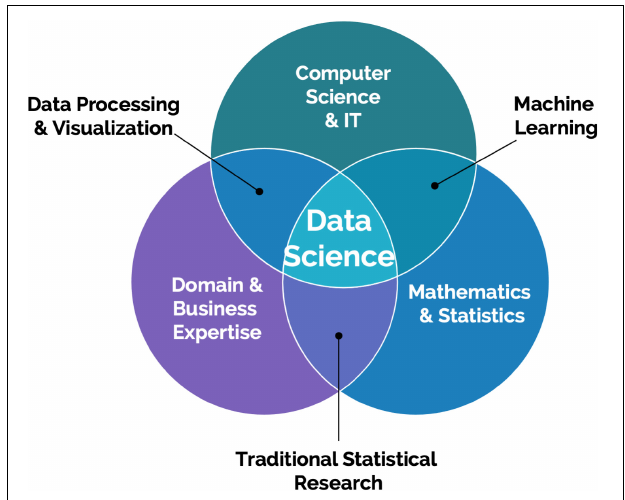
FIGURE 2 | Data Science is an interdisciplinary field focused on extracting knowledge from data. It requires a combination of skills, mainly statistics and mathematics, information technology understanding, and domain